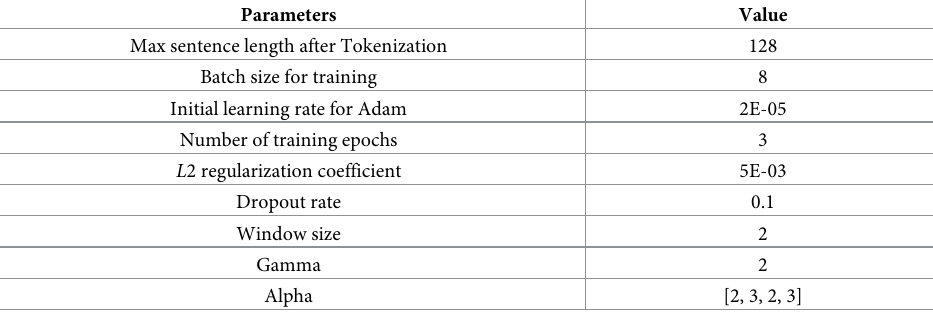
Table 8. The hyper-parameters of Bert for fine tune in SemEval-2018 Task-8 dataset.